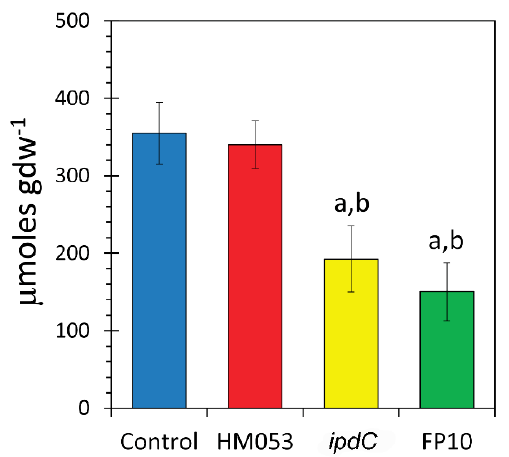
Figure 6. Kernel Zn content was measured using ion chromatography. Data reflect means for N = 12 replicates ( ± SE). Statistical significance p < 0.05 was designated by ‘a’ in the comparison of treat- ment type to untreated control, and ‘b’ in a comparison of ipdC or FP10 treatments to HM053 treat- ment.